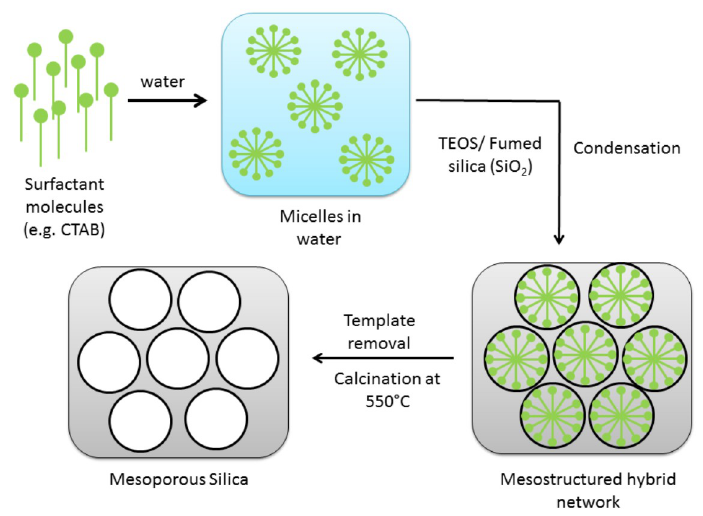
Figure 1. Overview of a synthetic approach to the mesoporous silica formation.